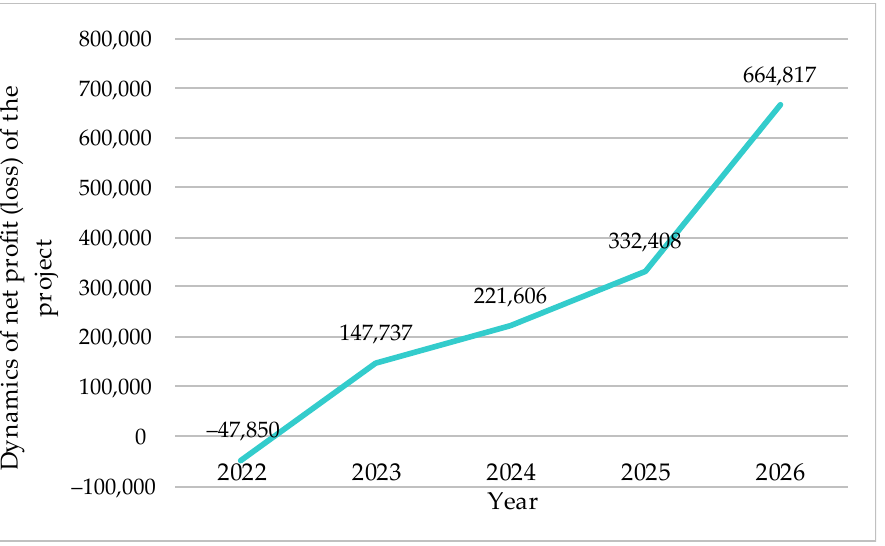
Figure 7. Dynamics of net profit (loss) of the Hideez project in 2022–2026, US dollars . All calculations correspond to the general methodology for determining economic results; namely the following indicators: cost structures for the promotion of innovative products; planned revenue from the sale of innovative products; projected gross profit; net profit (loss) of the project (Hahn 2020).